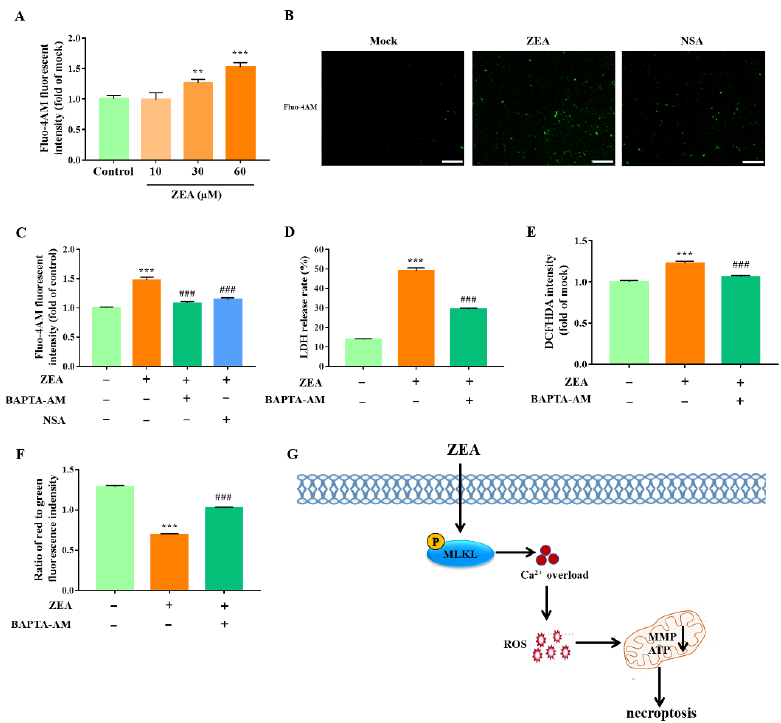
Figure 5. MLKL promotes ROS generation and mitochondrial dysfunction in gESCs by inducing Ca 2+ overload. ( A ) Cells were treated with ZEA at the indicated concentrations (10, 30, and 60 μM) for 24 h before Ca 2+ levels were assessed by Fluo-4AM staining. ( B ) Cells were pretreated with NSA (2.5 µ M) before treatment with ZEA (60 µ M) for 24 h. Fluo-4AM staining was performed to assess Ca 2+ levels. Scale bar, 100 μm. ( C ) Cells were pretreated with NSA (2.5 μM) and Ca 2+ chelation agent BAPTA-AM (1 μM) for 2 h, respectively, before treatment with ZEA (60 μM) for a further 24 h. Ca 2+ levels were detected by Fluo-4AM staining, and a fluorescence microplate read the data. D-G Cells were pretreated with BAPTA-AM (1 µ M) for 2 h before treatment with ZEA (60 µ M) for a further 24 h. ( D ) LDH release was assessed using a cytotoxicity LDH assay kit. ( E ) ROS generation was measured by DCFH-DA, and the fluorescence intensity was present by a fluorescence microplate. ( F ) The mitochondrial membrane potential was assessed by JC-1 staining, and the data were quantified using a fluorescence microplate. ( G ) Schematic model delineating the pathway of the necroptosis caused by ZEA in gESCs. ** p < 0.01, *** p < 0.001 vs. control group. ### p < 0.001 vs. ZEA